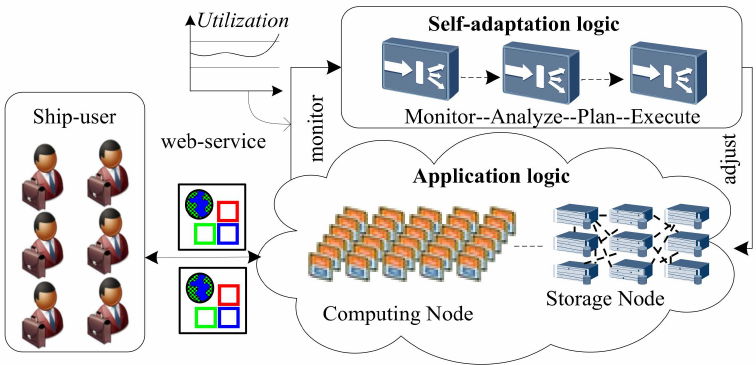
Figure 1. Architectural view of